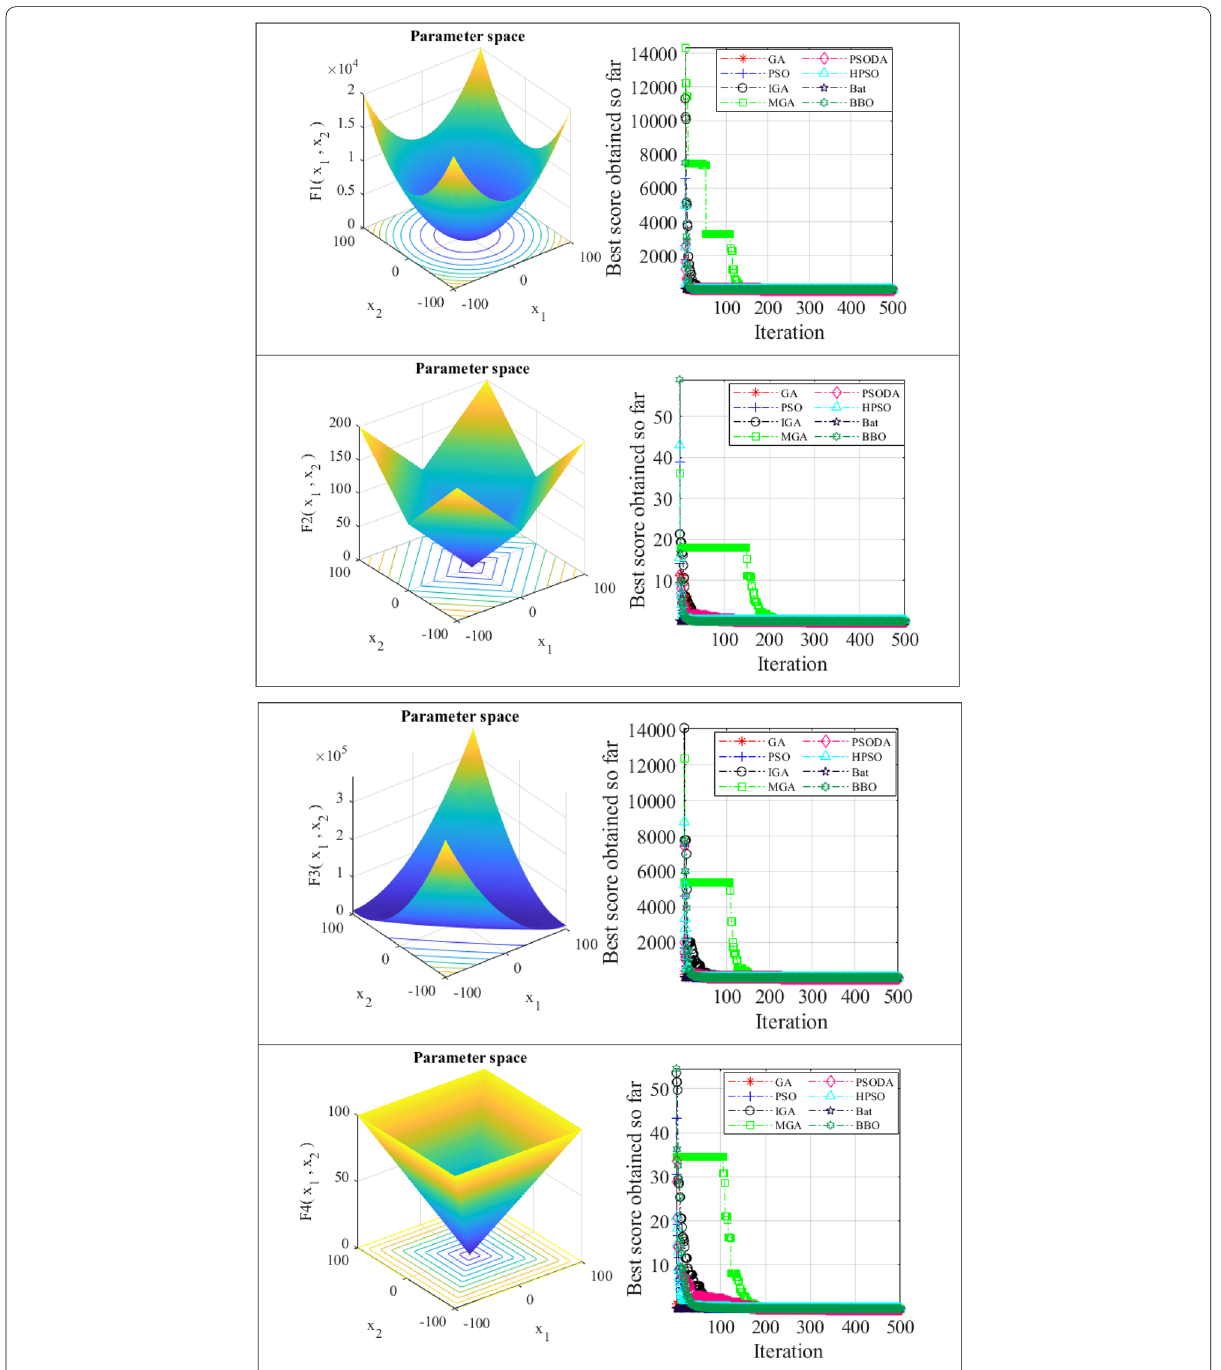
Fig. 8 Convergence curve of different compared